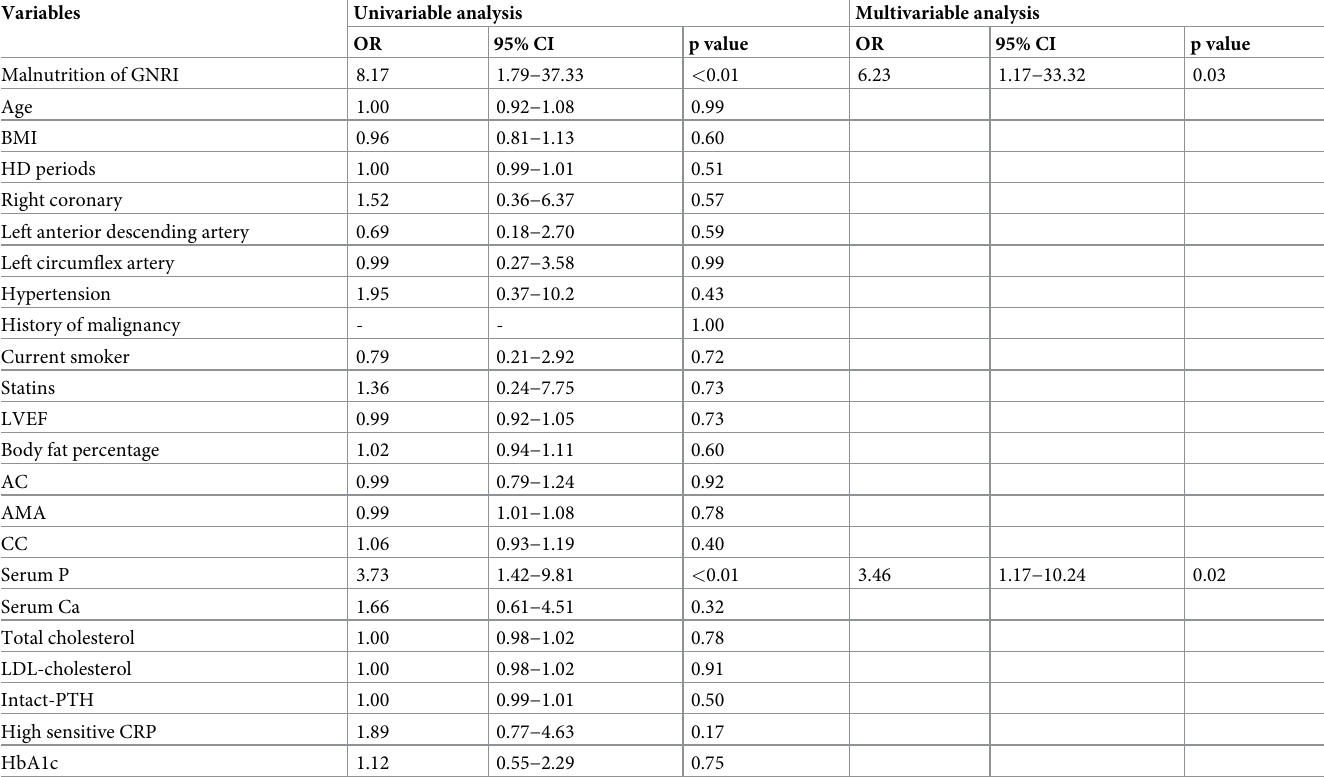
Table 6. Predictors for progression of vascular